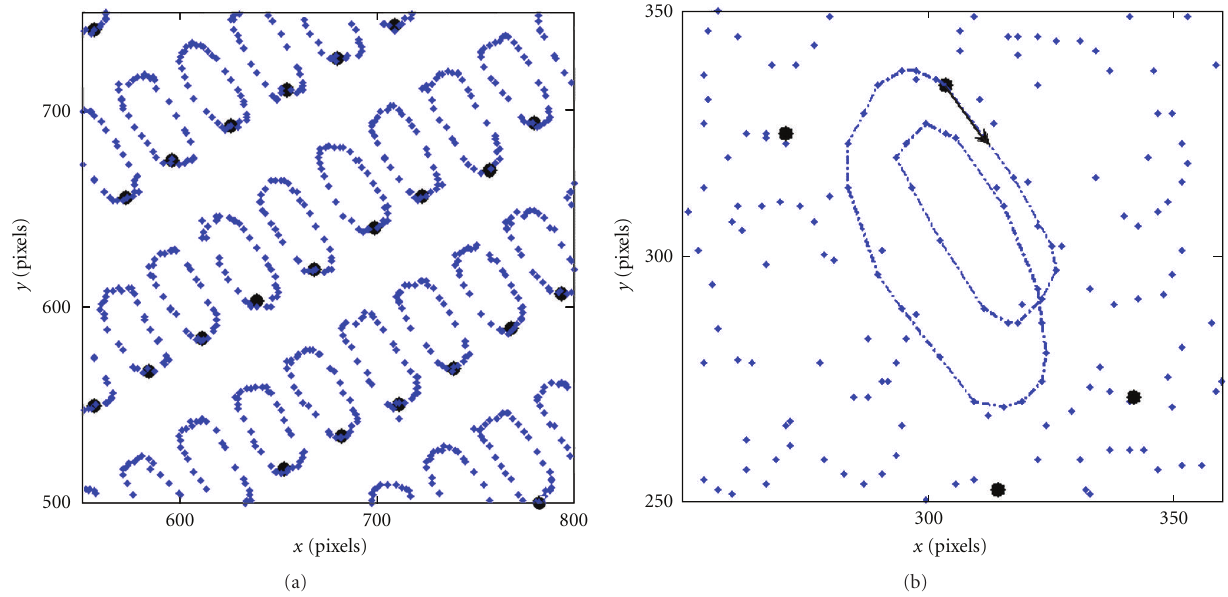
Figure 7: The trajectory of vortex points measured when a quarter wave plate is inserted between the Wollaston prism and rotated (a). The same situation applies but the quarter wave plate is wedge-like. Figure on the right shows part of the whole